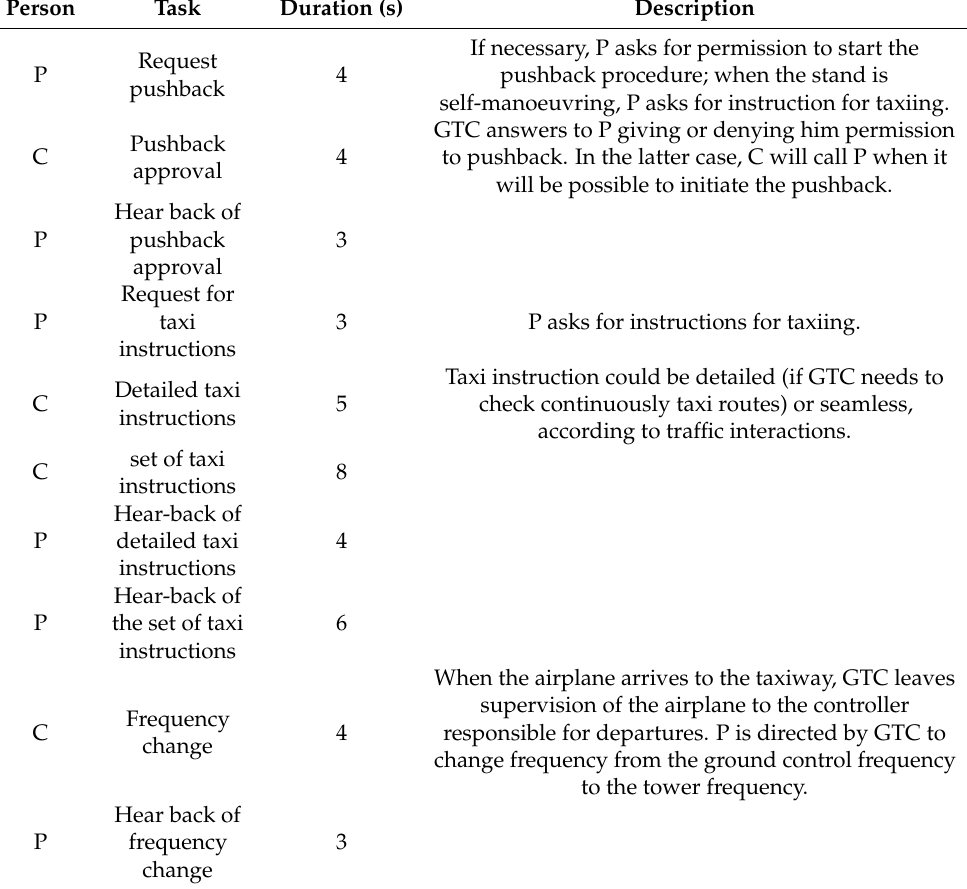
Table 3. Tasks of GTC.